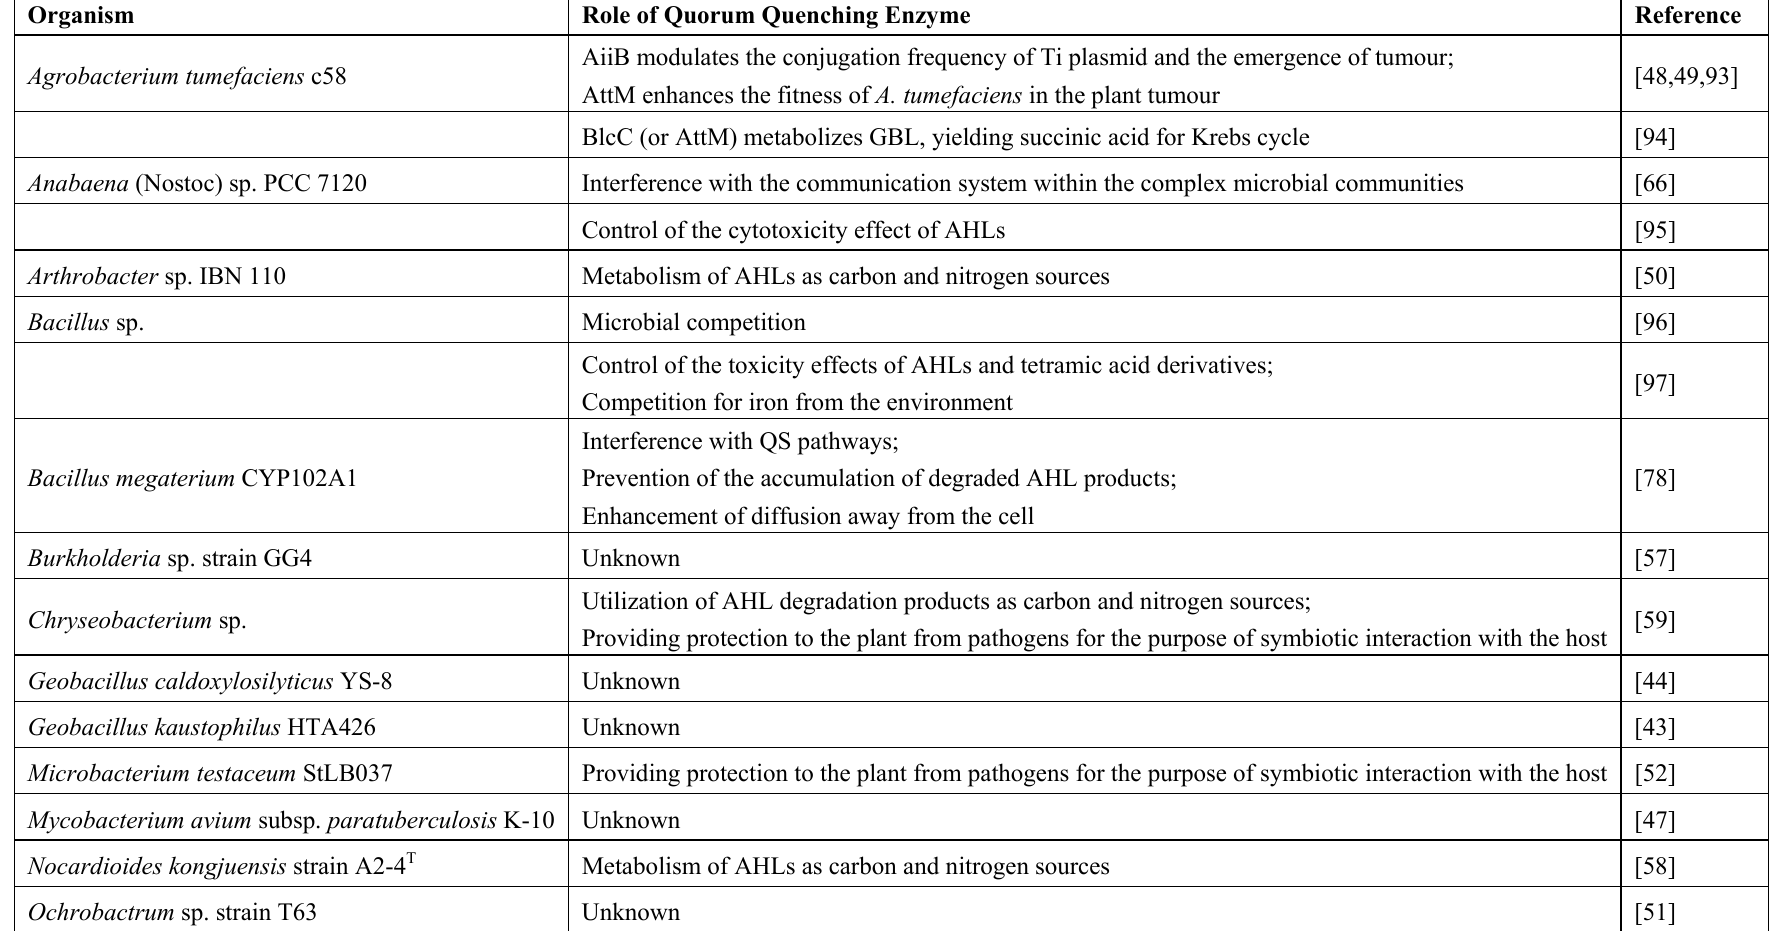
Table 2. The roles of quorum quenching